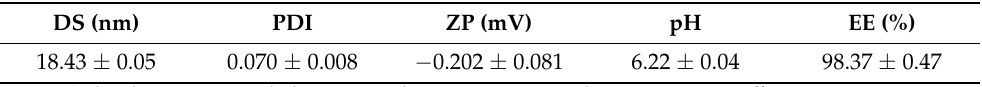
Figure 6. Appearance ( a ), size distribution ( b ) and TEM image ( c ) of the LCZ-NE. Scale bar = 100 nm. Table 2. Physicochemical properties of the optimized